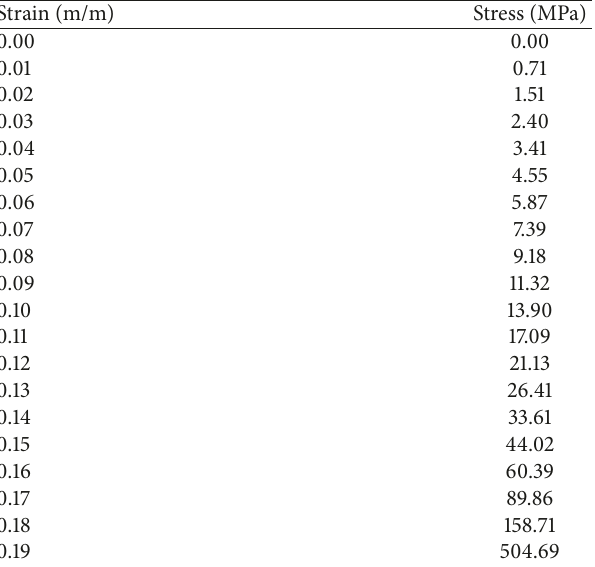
Table 5: Cap pressures for the double yield